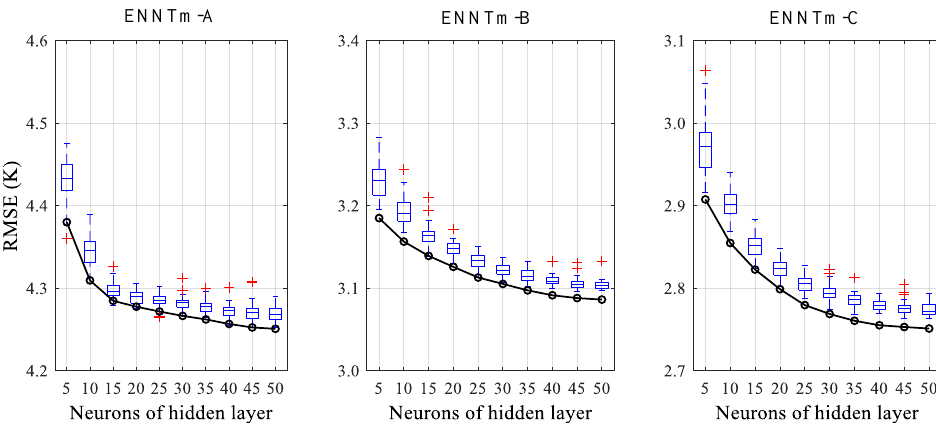
Figure 5. The RMSE of different modeling schemes with different BPNN